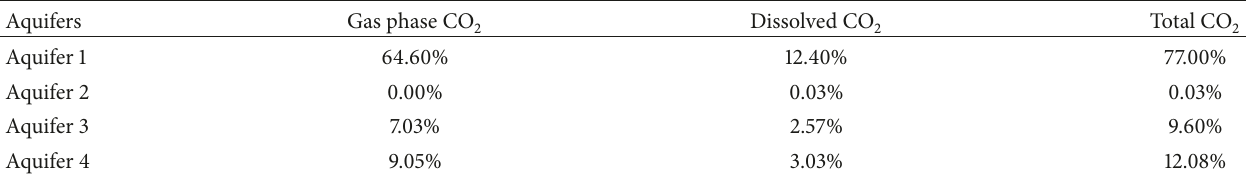
Table 5: CO 2 mass distribution in percentage among each aquifer after one year’s injection.